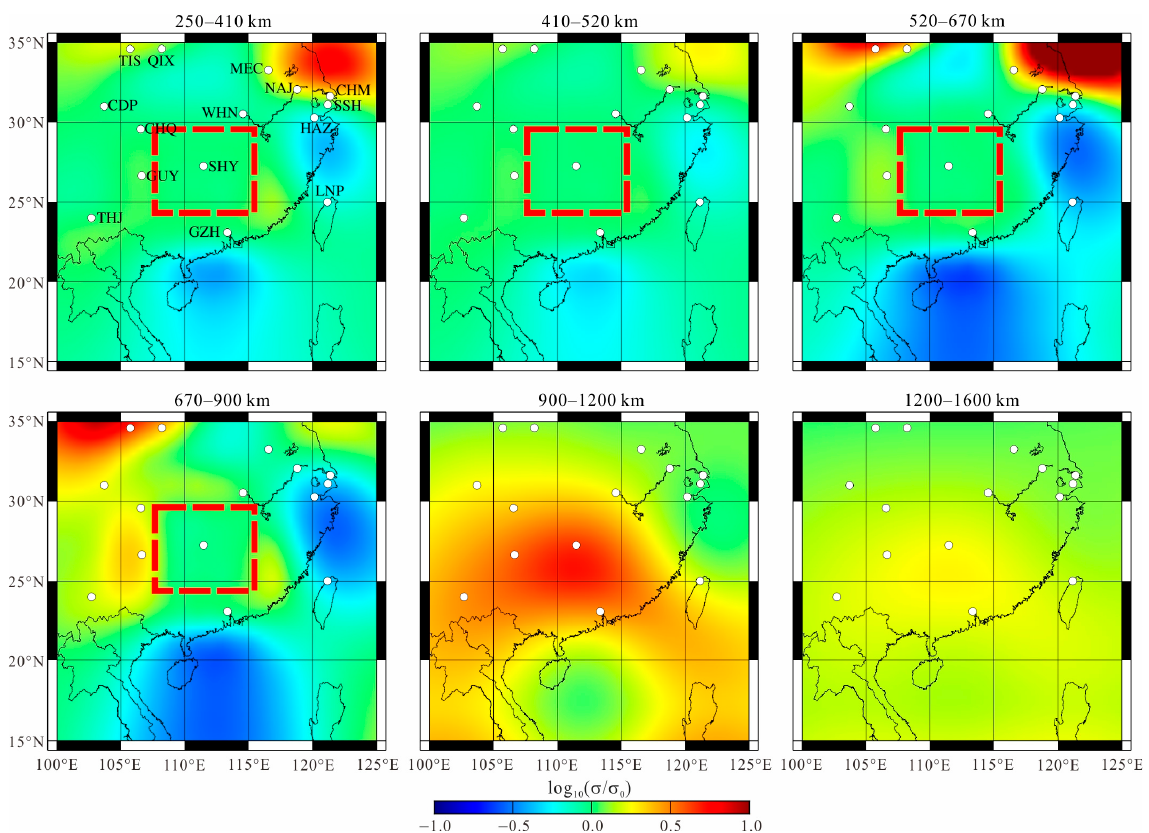
Figure 9. The inversion results of restricting the area (between depths of 250 km and 900 km, marked by red dotted rectangles) to be resistive and fixed during inversion.